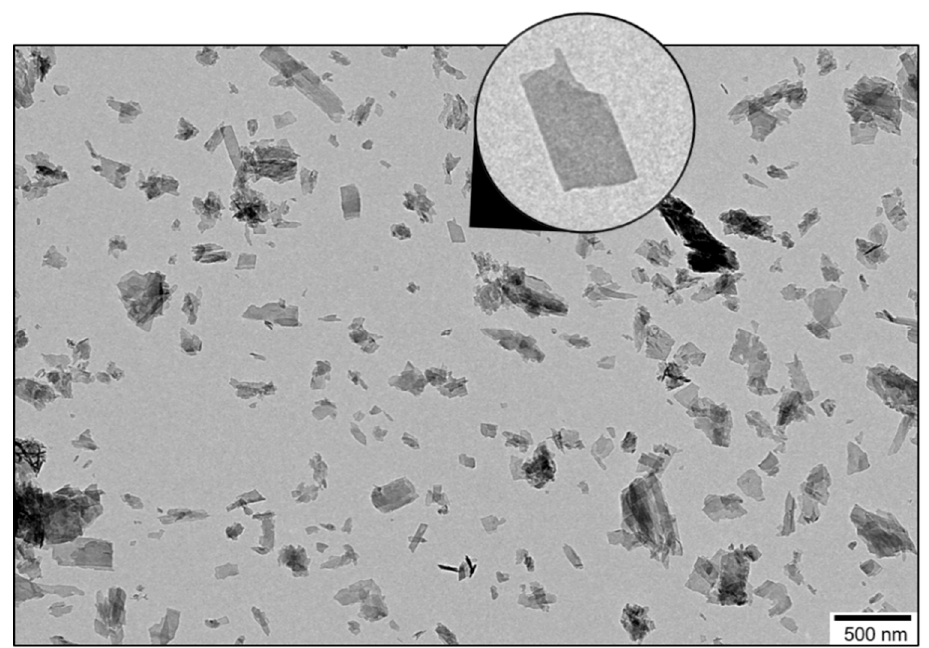
Figure 1. Morphological features of the bone-like hydroxyapatite particles. A representative transmission electron micrograph (TEM) of the synthetic Carbonated HydroxyApatite (CHA) particles. The inset shows a magnification of a single particle, which indicates that CHA is in the form of nanosized elongated platelets.